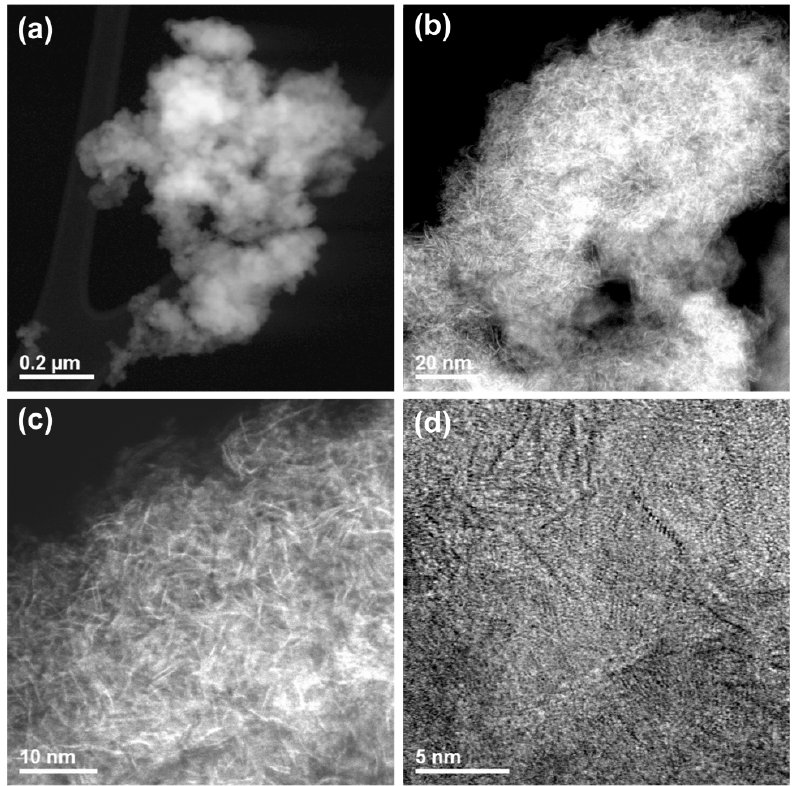
Figure 4. ( a – c ) High-angle annular dark-field (HAADF) scanning transmission electron microscopy (STEM) and ( d ) high-resolution transmission electron microscopy (HRTEM) images of ReS 2 /C composite.